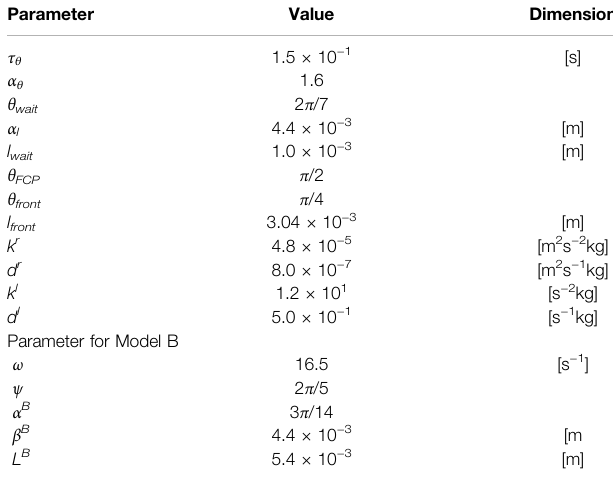
TABLE 1 | Body parameter values employed in the simulations. TABLE 2 | Control parameter values employed in the